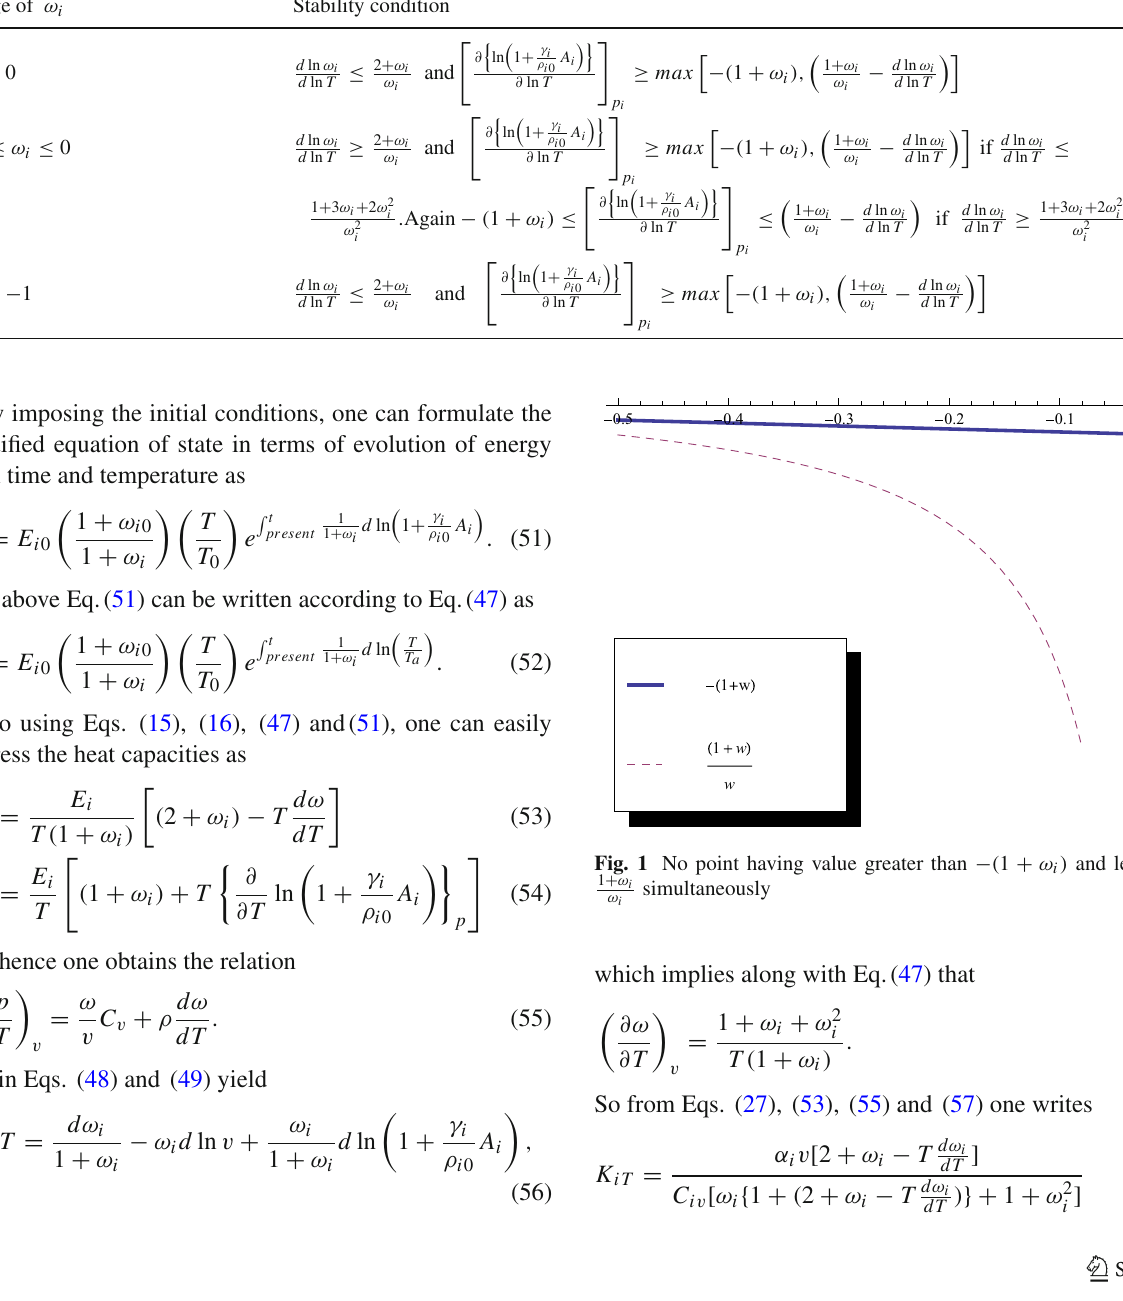
Table 2 Conditions for stability criteria Range of ω i Stability condition